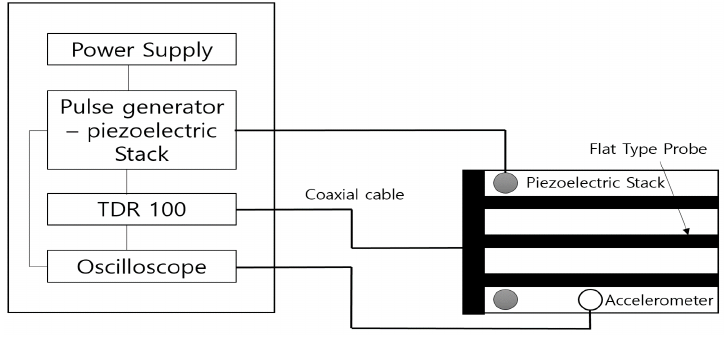
Figure 6. Schematic diagram of the new TDR system.